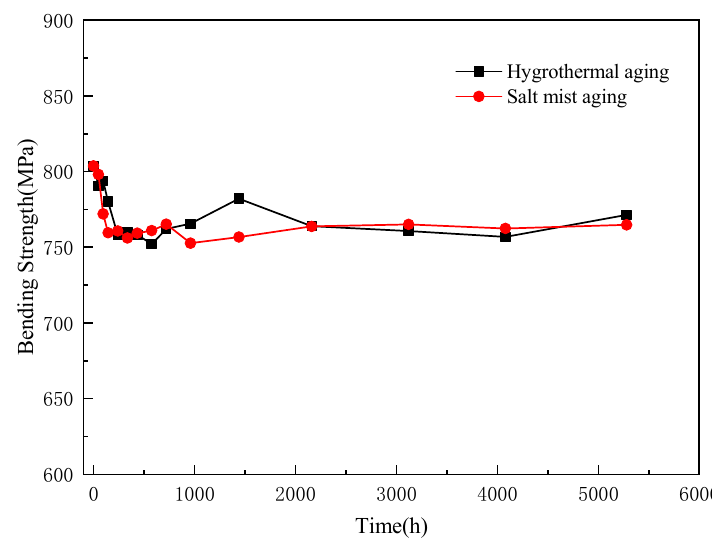
Figure 10. Variations in the flexural strengths of the composites.